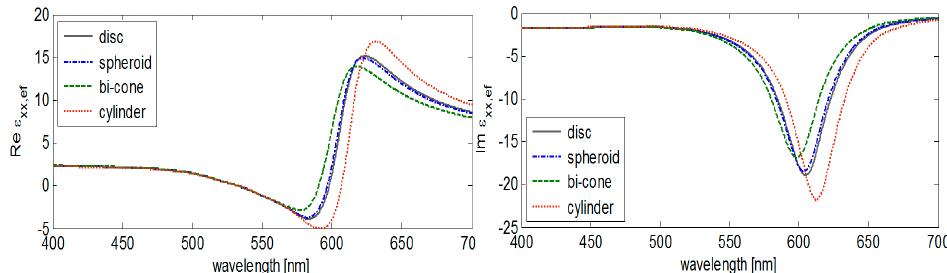
Figure 4. Shape dependent effective permittivity of system Au/polyacrylate (height/diameter = 10/5 nm, fill factor 0.2) for typical forms of nanoparticles.